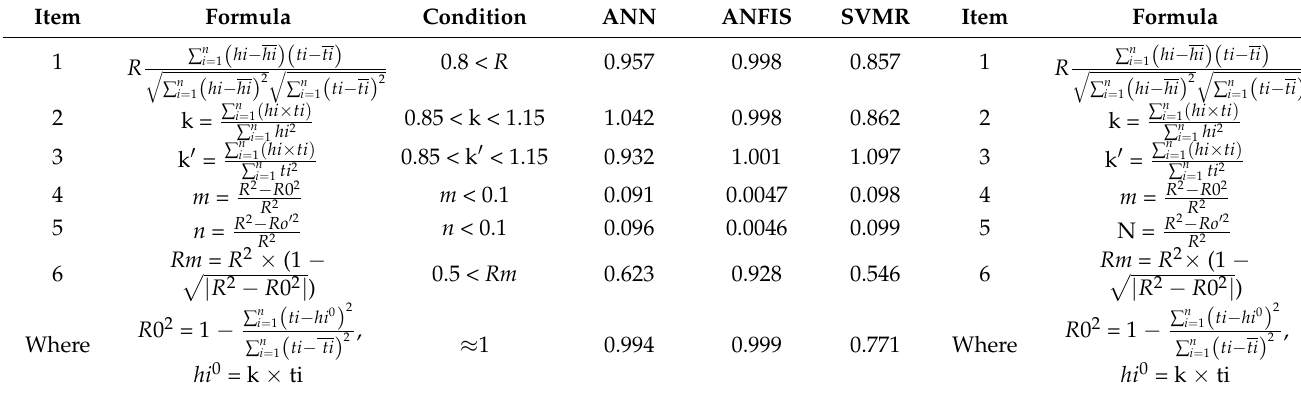
Table 9. The validation and performance of constructed